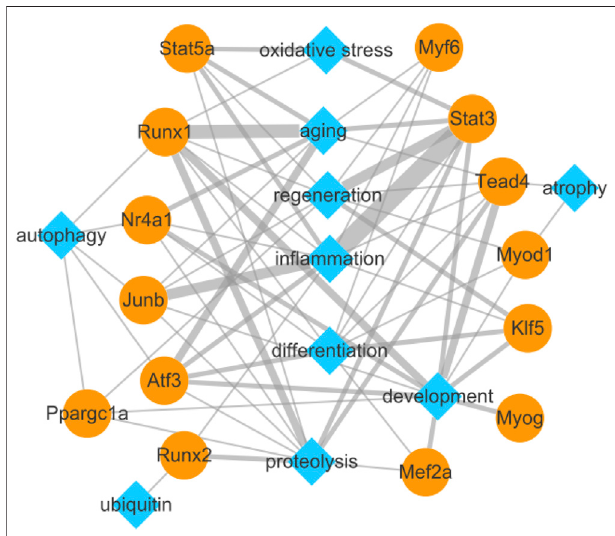
FIGURE 7 | Biological function network of differentially expressed transcription factors and their target genes related to pathophysiology of skeletal